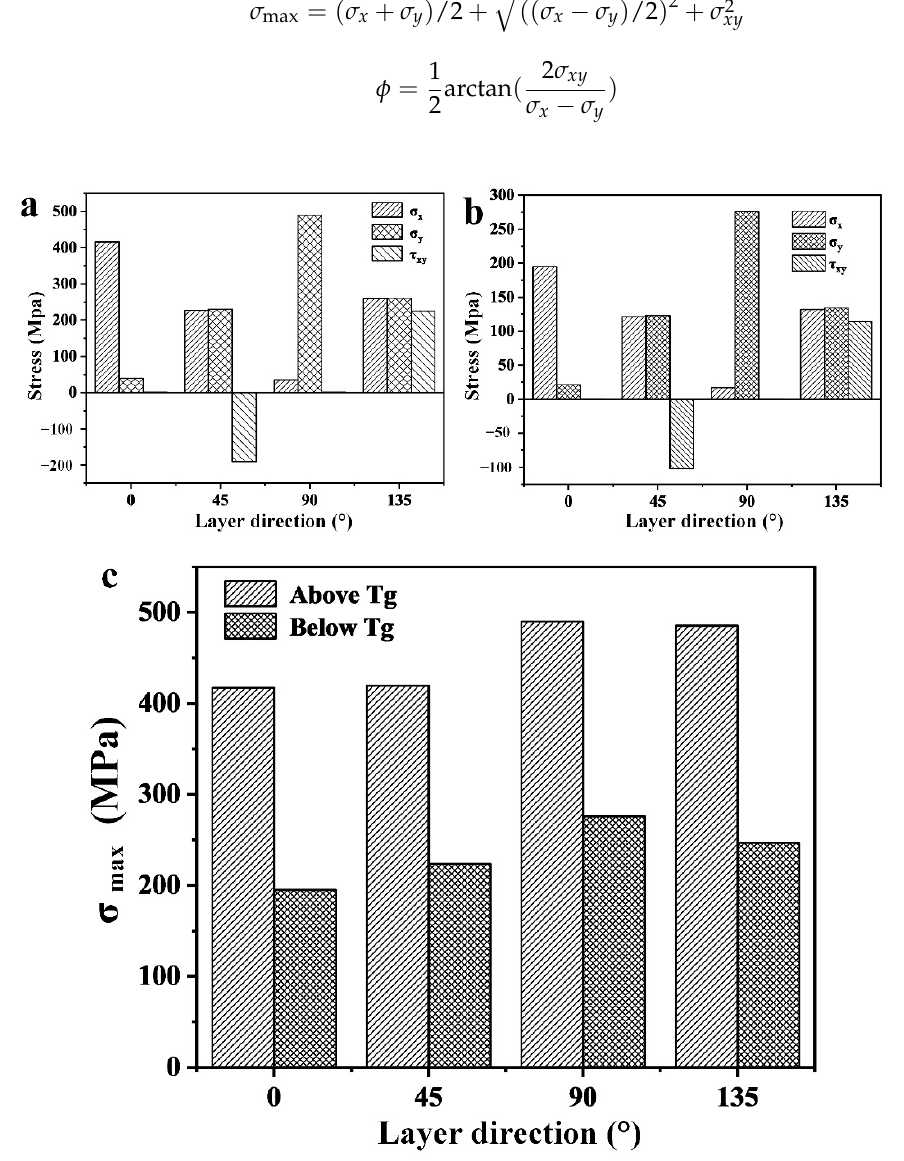
Figure 10. Results of the through-hole drilling method: ( a ) residual stress of specimen drilled at 40 °C ; ( b ) residual stress of specimen drilled at − 30 °C ; and ( c ) maximum primary stress of specimen.